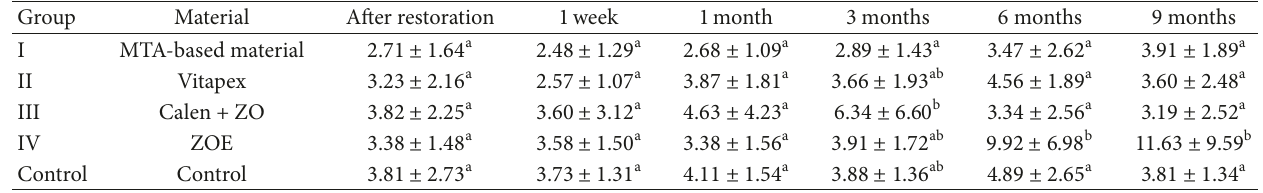
Table 3: Mean and standard deviation of variation in color values ( Δ𝐸 ∗ 00 in the different experimental groups.